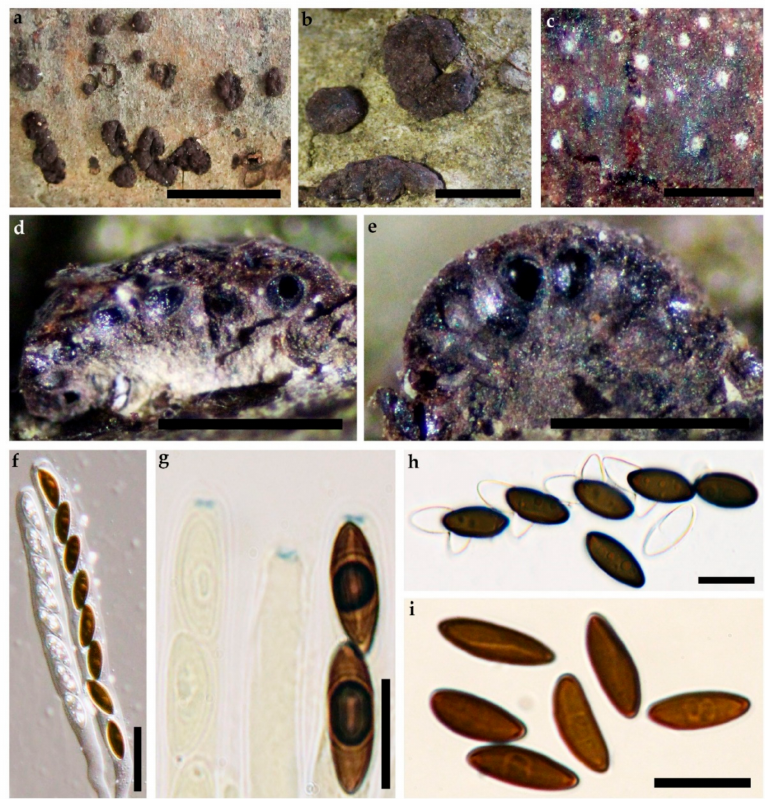
Figure 4. Hypoxylon pseudofuscum (Holotype). ( a , b ) stromatal habit; ( c ) close-up view of stromatal surface; ( d , e ) stroma in section showing perithecia and ostioles; ( f ) mature and immature ascus in water; ( g ) mature and immature asci tips in Melzer’s reagent; ( h ) ascospores in 10% KOH with dehiscent perispore; ( i ) ascospores in water, with sigmoid germ-slit. Scales bars set as ( a ) 1 cm; ( b ) 2.5 mm; ( c – e ) 1mm; ( f ) 20 µ m; ( g – i ) 10 µ